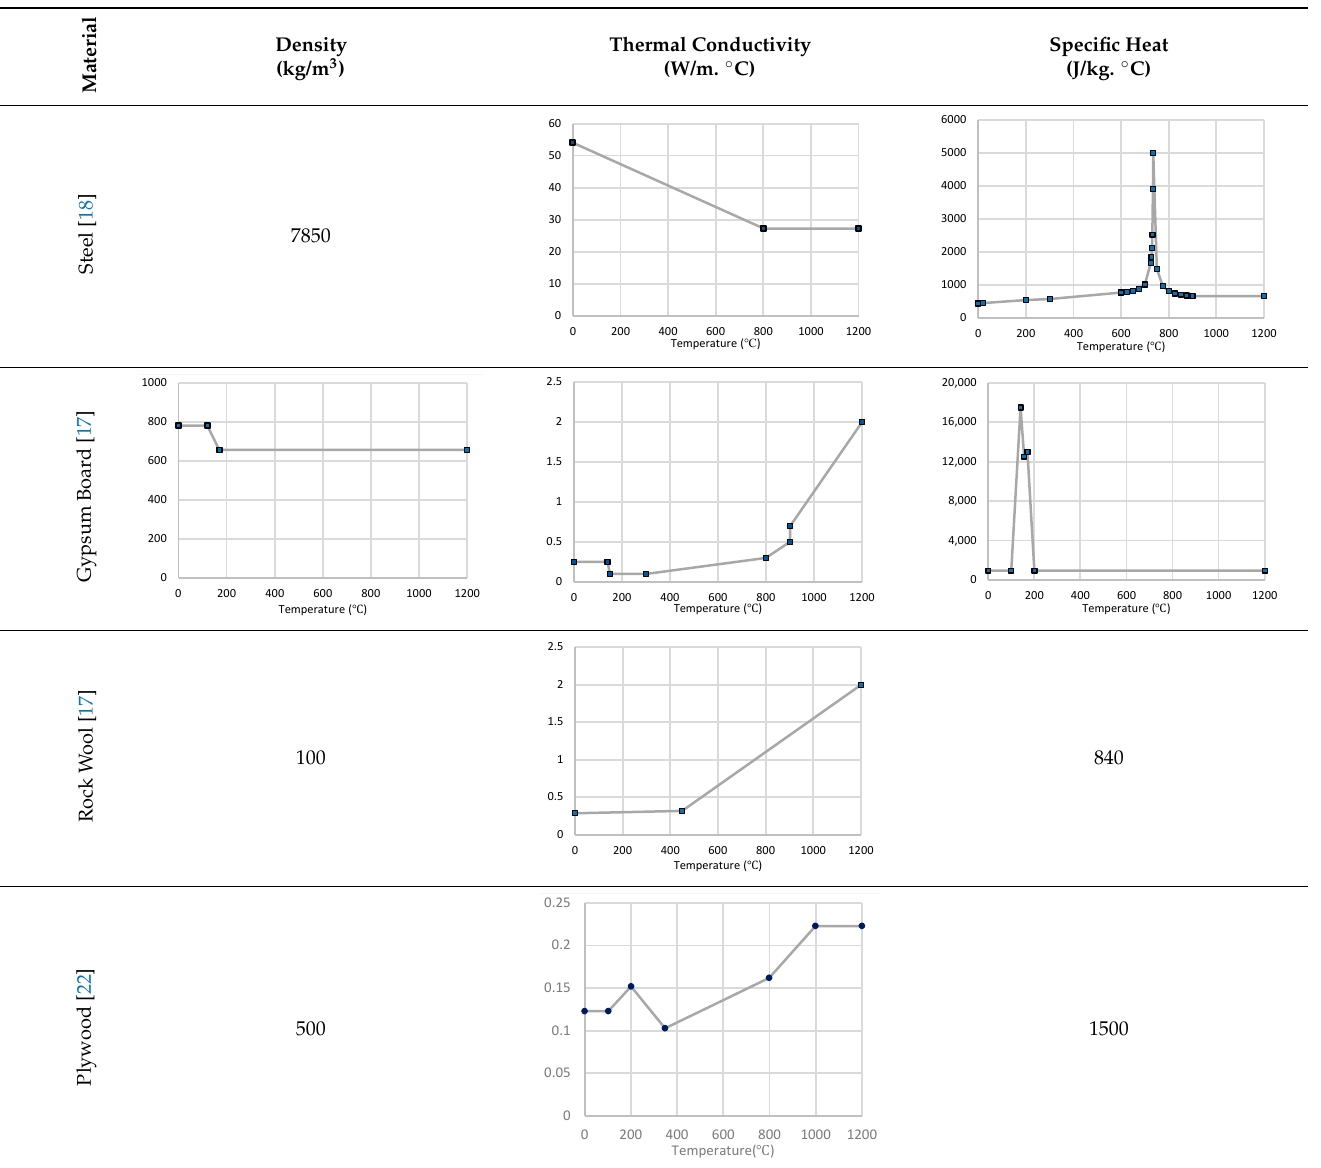
Table 2. Thermal properties of the materials involved in the numerical study.